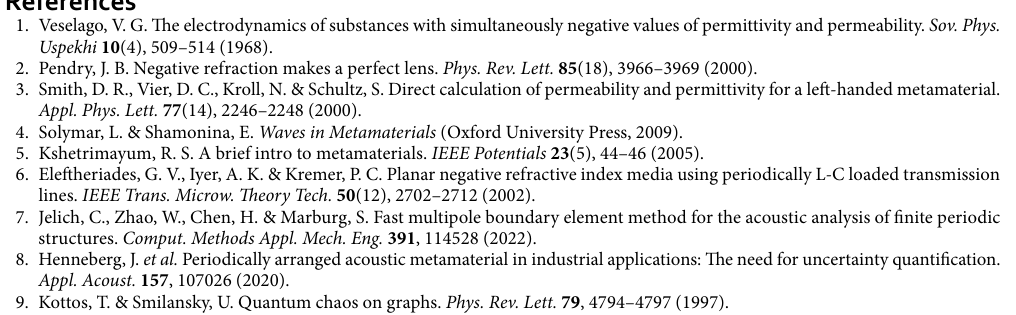
Figure 13. Top: The iso-frequency contours of three metamaterials with properties defined by scattering 0, 4.45 ) and 1 / l . Bottom: The real component of a Gaussian beam (cid:31) ( k S Ŵ matrices ˆ S Ŵ , ˆ S Ŵ for k ˆ point point cross ; = incident from material 1 constructed from the full wave field (cid:31) nm for an incident wave from metamaterial 1, 0 1 , and no incident wave from material 3, B 3 A 1 = =